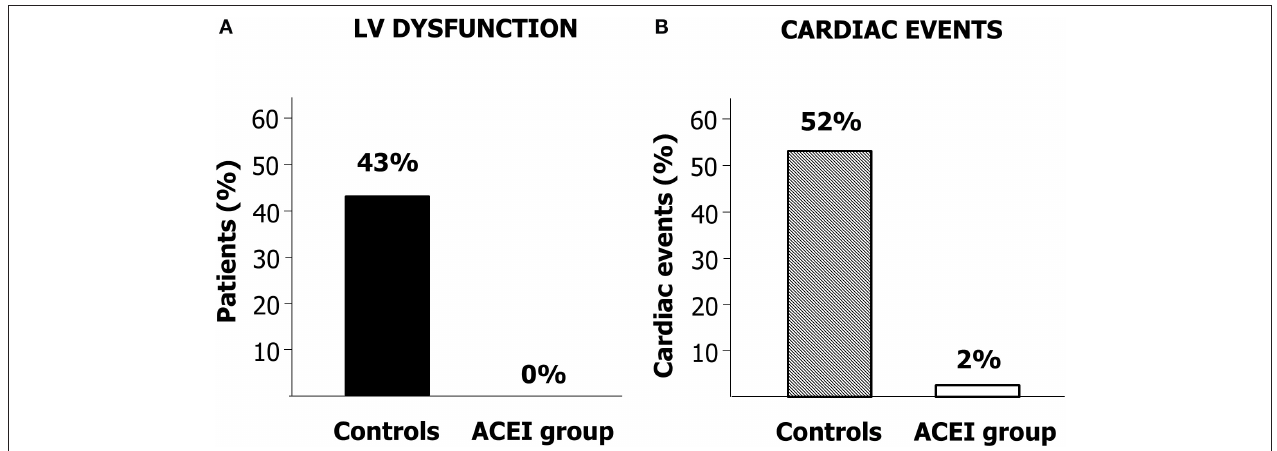
FIGURE 5 | (A) Percentage of patients developing cardiac dysfunction in the enalapril-treated group (ACEI Group) and controls. (B) Incidence of cardiac events in patients treated with ACEI Group and in Controls. Modified from Cardinale et al. (90).